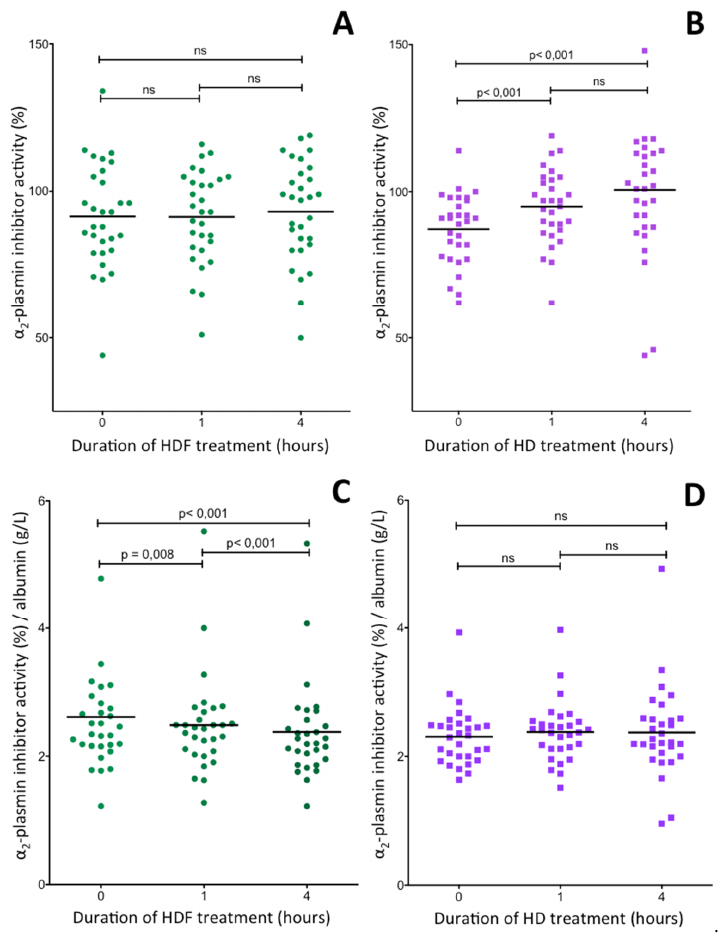
. Figure 6. Changes of plasma α 2 PI activity in ESRD patients during a 4-h HDF ( A , C ) or HD ( B , D ) treatment. The upper two figures show α 2 PI activities not corrected for albumin ( A , B ), while α 2 PI activities corrected for albumin concentration are shown in the two lower figures ( C , D ). The horizontal lines represent mean activities. Significant di ff erences between results obtained before and after treatments are indicated by the p values above thin horizontal